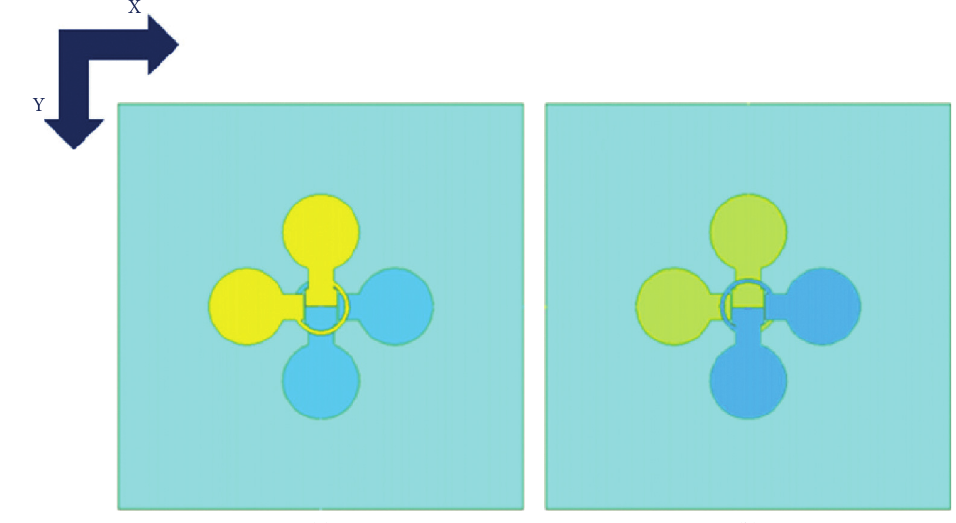
Figure 10: Both faces of UCPCA geometry: (a) top and (b)